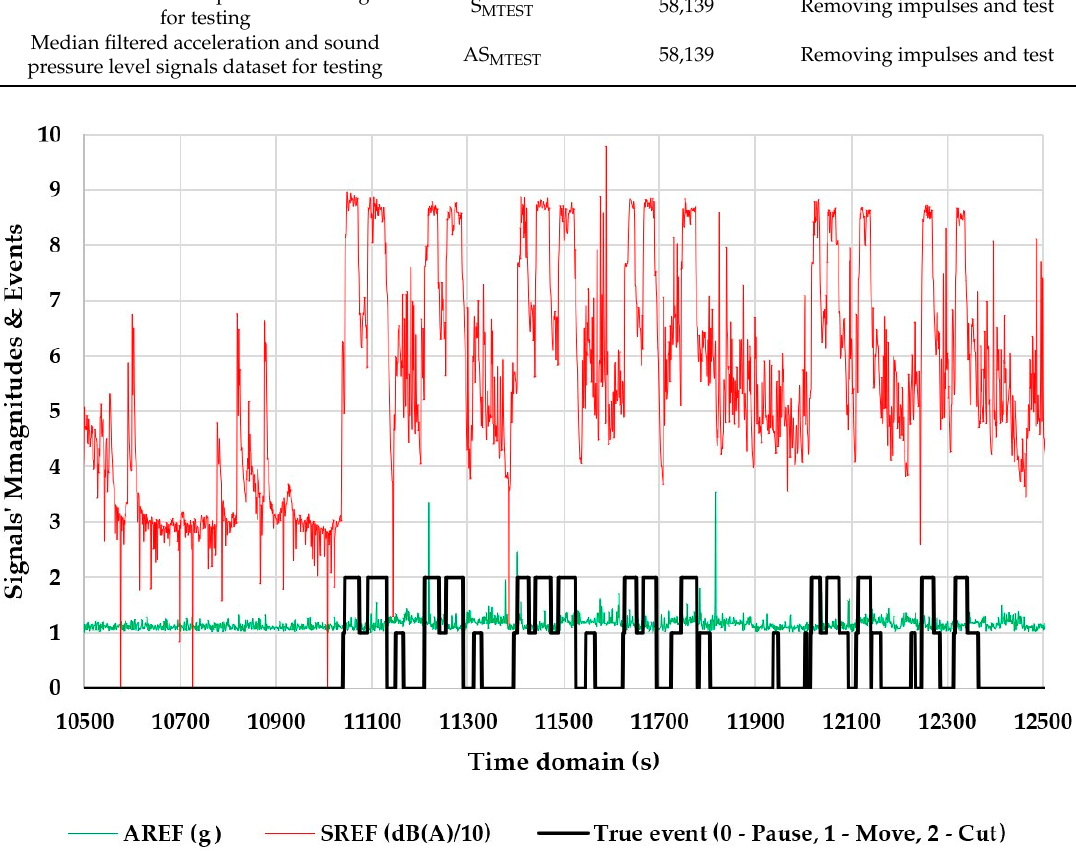
Figure 2. A partition of the refined signal datasets showing the true events in the time domain. Legend: A REF - refined acceleration signal dataset, S REF - refined sound pressure level signal dataset.